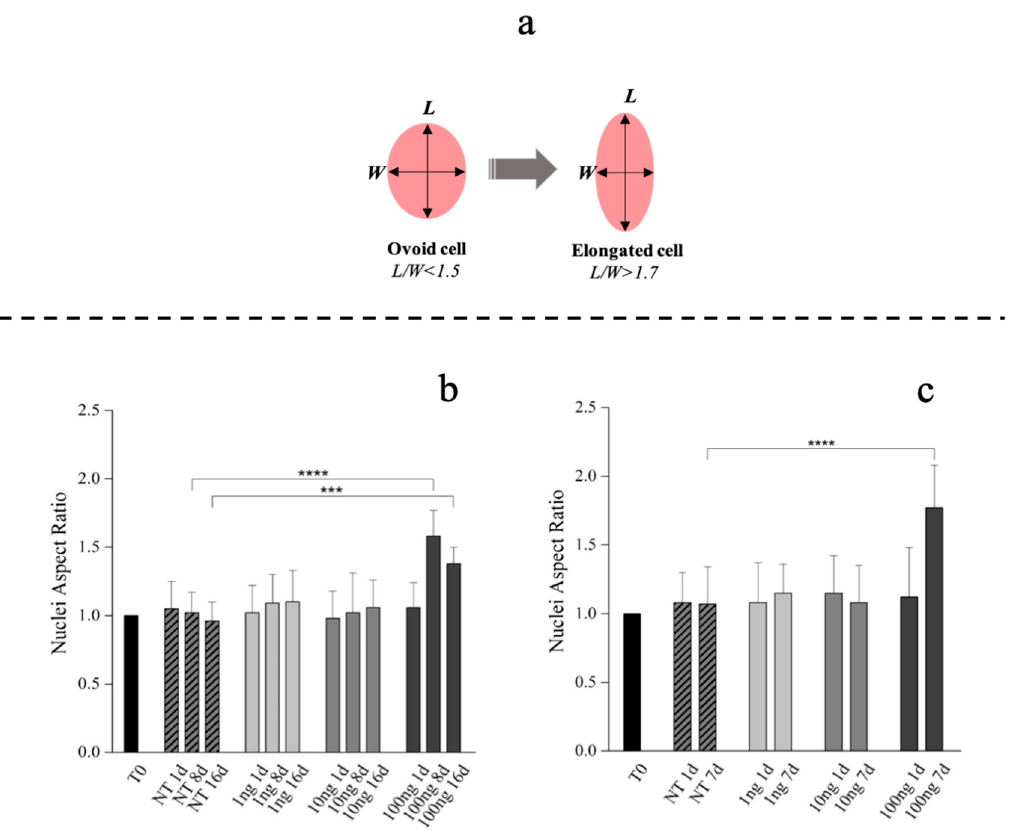
Figure 3. Morphometric analysis of hBM-MSCs and hWJ-MSCs with the hGDF-5 dose-dependent e ff ect. Shape modification analysis illustrated the hGDF-5 concentration-dependent e ff ect on cells ( a ). Nuclei aspect ratio vs. treated cells are reported for hBM-MSCs ( b ) and hWJ-MSCs ( c ); data on untreated cells are also reported for comparison purpose. Statistically significant di ff erences are